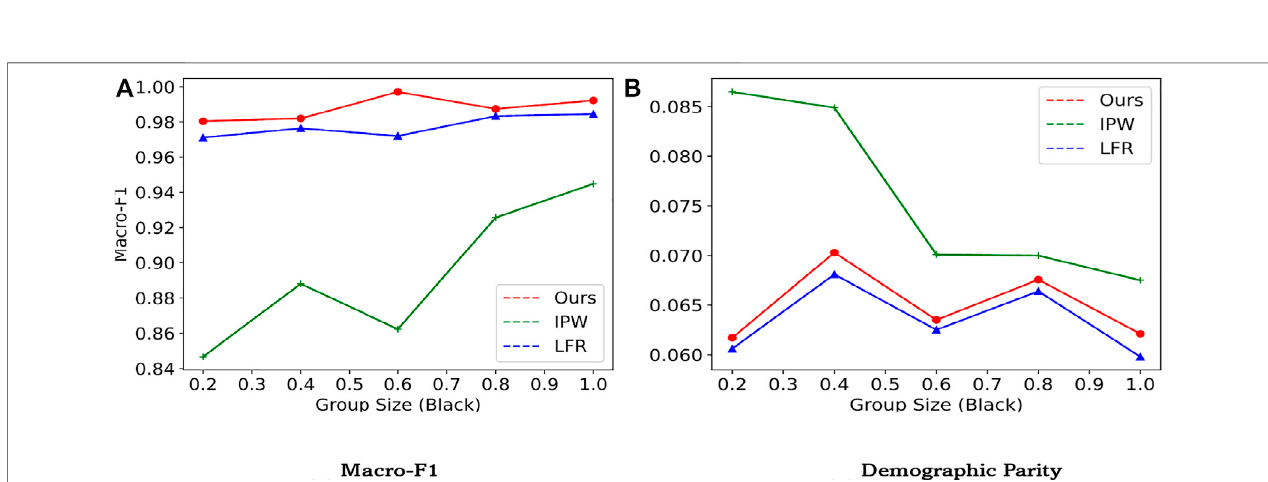
FIGURE 4 | Classi fi er performance (F-1 score) and fairness as a function of the amount of black examples. For F-1, the higher, the better. For selection rate, the lower, the better. (A) Macro-F1 (B) Demographic Parity